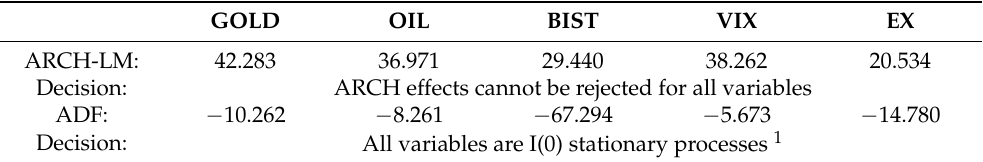
Table 3. ARCH-LM and ADF test